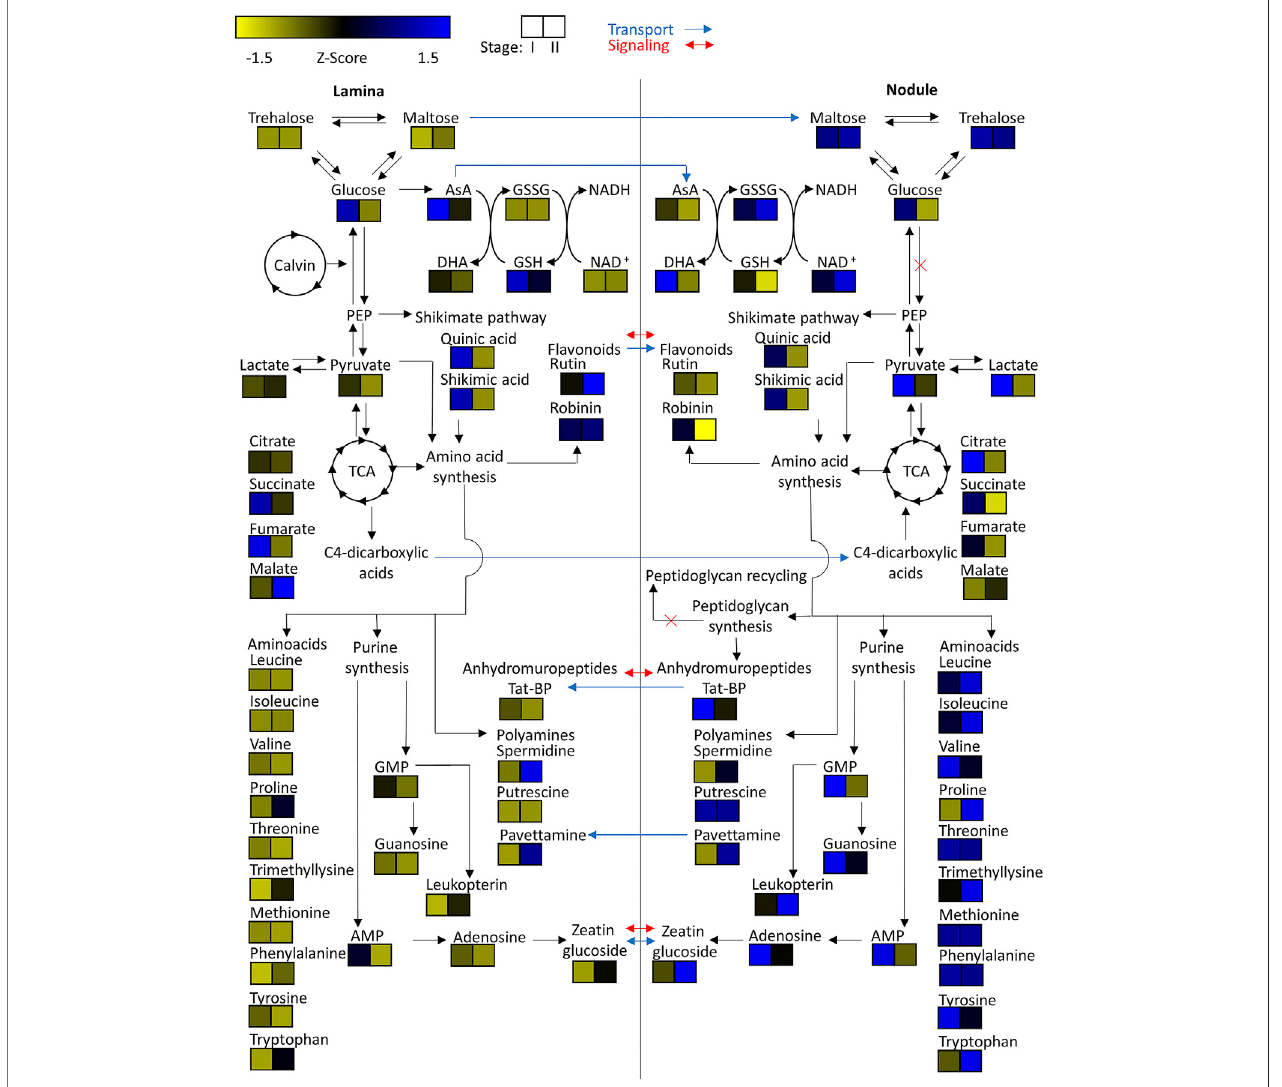
FIGURE 8 | Heatmap of z-scored means of selected m/z features of Psychotria punctata tissue extracts illustrated within their connected metabolic pathways. Possible metabolite transport is denoted by a blue arrow and possible signaling is denoted by a red arrow.